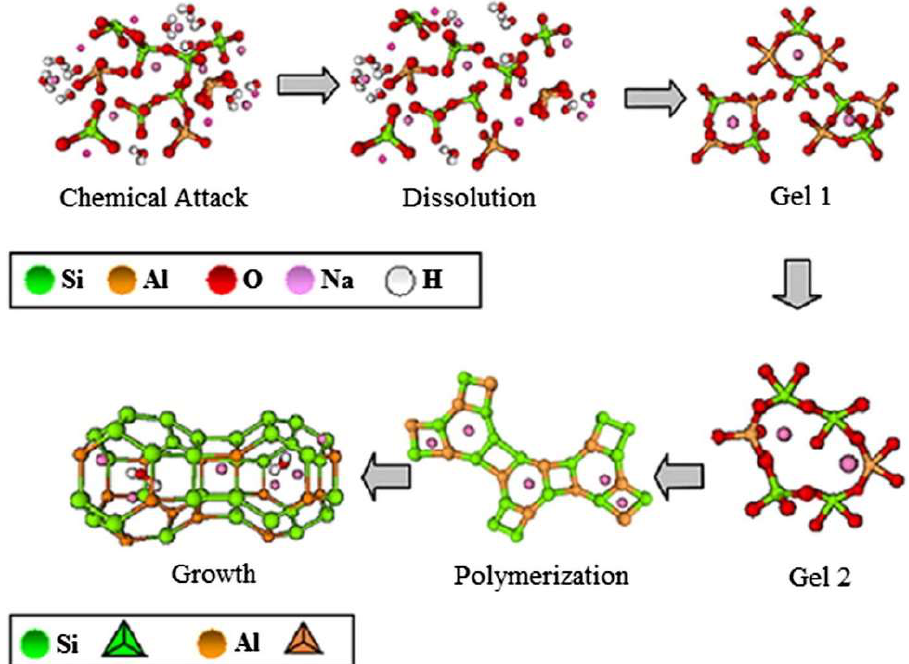
Figure 17. Structural model of three dimensional geopolymers [86].